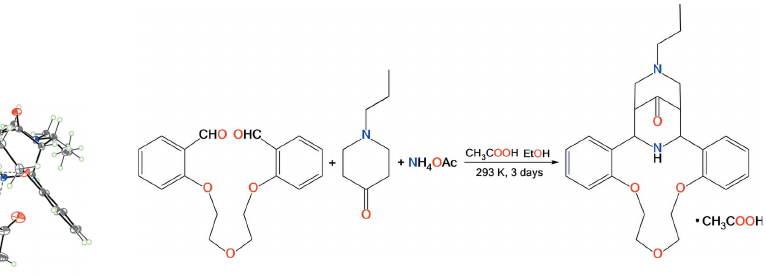
Figure 1 Petrenko–Kritchenko condensation of N -propylpiperidinone with